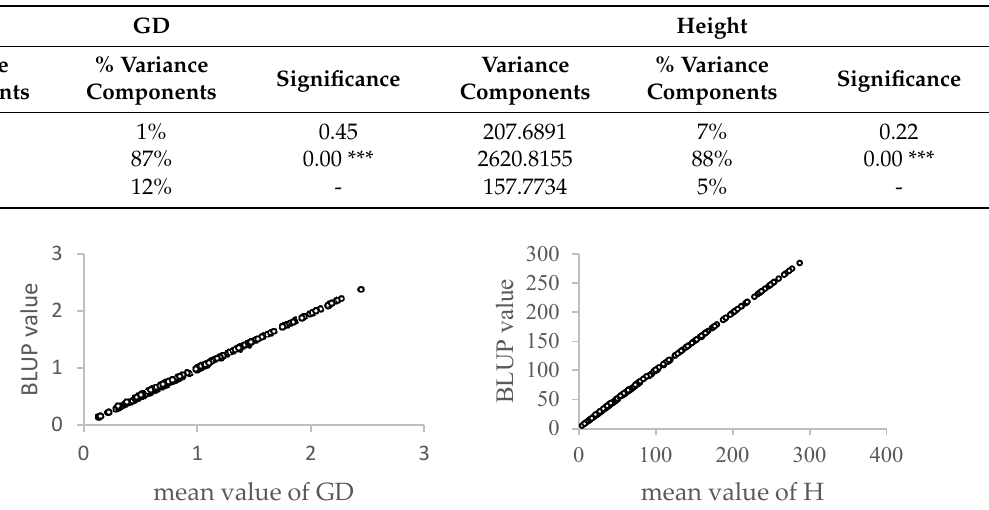
Table 6. Random-effects analysis. ‘***’ means extremely significant ( p < 0.01).